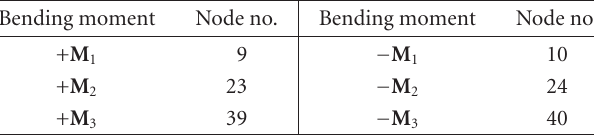
Figure 8: Finite element model of the HP turbine and IP turbine.